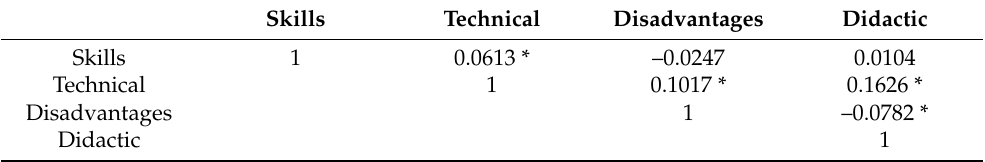
Table 3. Pearson correlation statistics of the responses of the different families of questions.